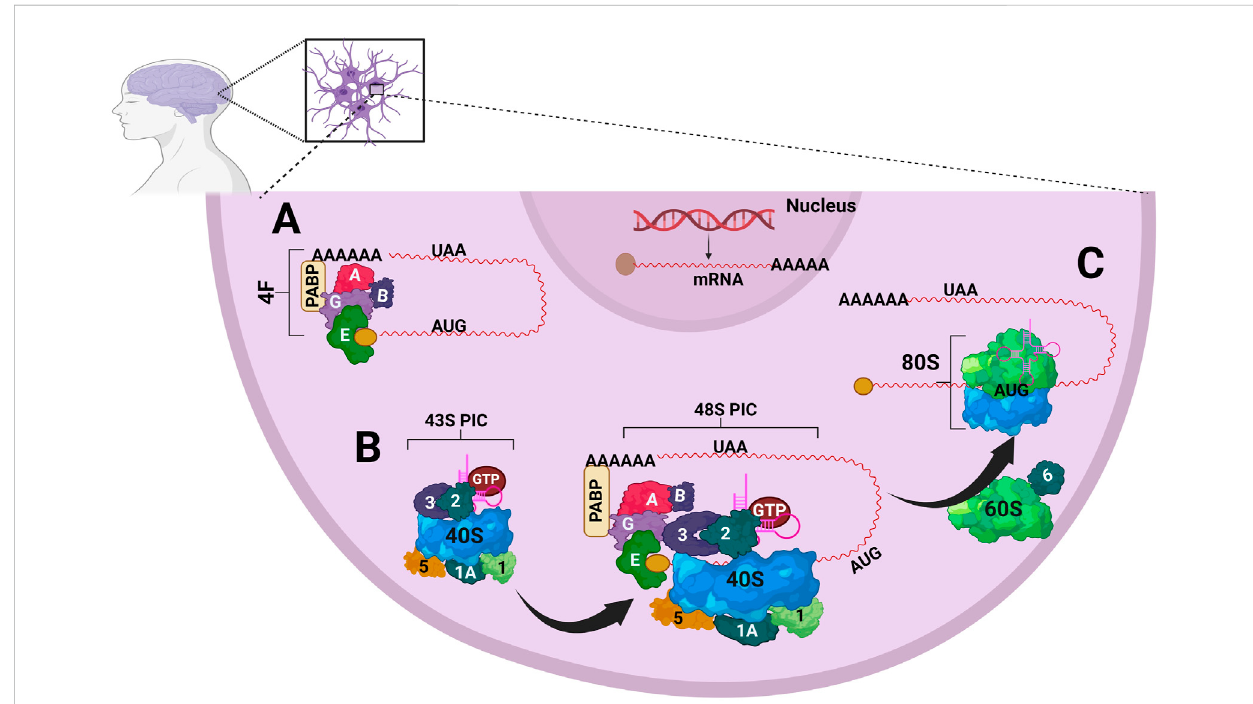
FIGURE 1 A summary of the translation initiation. eIFs are shown only with the respective numbers . (A) This process begins with forming the eIF4F complex ( 4F ). (B) . A free 40S ribosomal subunit interacts with eIF1, eIF1A, eIF3, eIF5, and the TC (eIF2 C Met-tRNAi Met C GTP), forming a 43S pre-initiation complex ( PIC ).A43SPICisrecruitedtothe5 ′ endofthemRNAthroughtheinteractionofeIF3andeIF4Gboundtotheribosomeresultingintheformationofa 48S PIC .Poly(A)bindingprotein( PABP )bindstothepoly(A)tailatthe3 ′ endofthemRNAandtoeIF4G.TheseinteractionscircularizethemRNA. (C) GTP- eIF5B promotes eIF1 and eIF5B release, facilitating the association of a 60S subunit to the 48S PIC resulting in the assembly of an 80S initiation